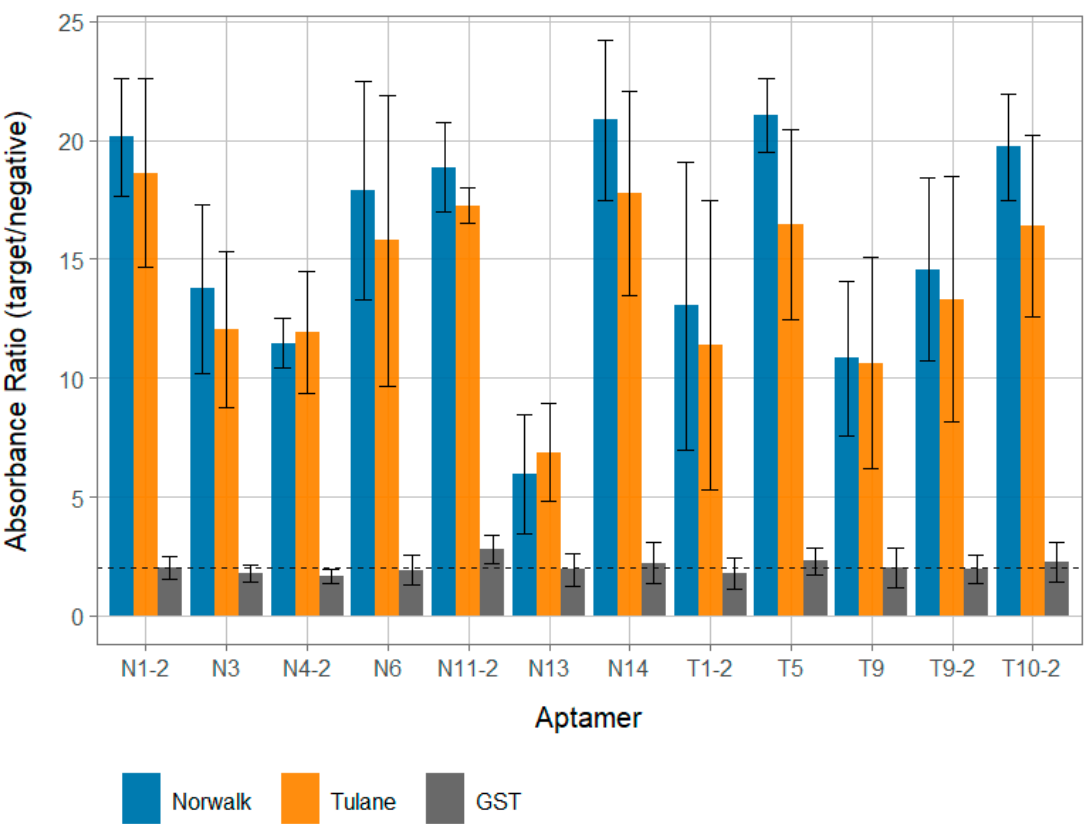
Figure 1. Affinity of aptamer VPg candidates. The relative binding ratios of each of the developed aptamers against Norwalk (blue) and Tulane (orange) VPg proteins were analyzed for each aptamer candidate. Further, binding to GST protein for each is visualized with grey bars. All ratios represent the ratio of positive absolute absorbance to absorbance for PBS only (no protein) wells. Aptamers that begin with “N” were generated against the Norwalk VPg and aptamers with a “T” in their name were generated against the Tulane VPg. Per convention, a ratio <2.0 is little to no binding, 2.0–5.0 low binding, 5.0–10.0 moderate to strong binding, and >10.0 very strong binding [5,18,34,35].